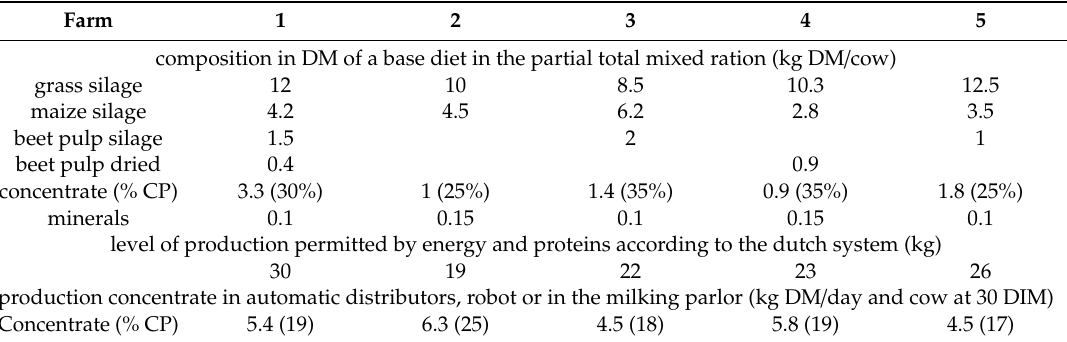
Table 1. Composition of diets in the 5